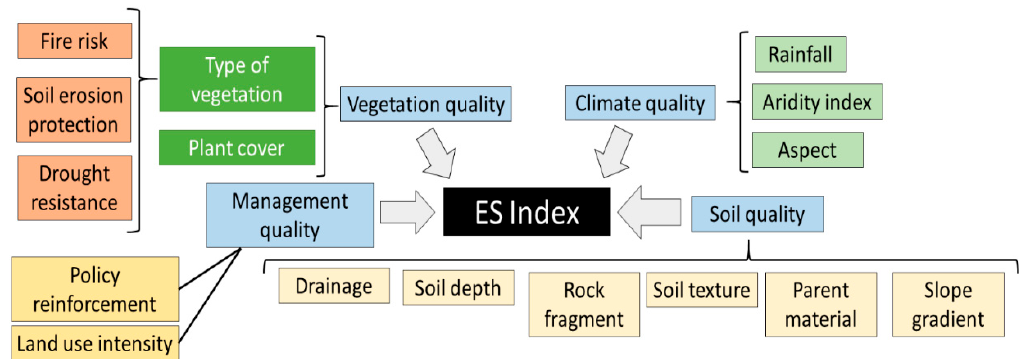
Figure 3. A graphical workflow of input variables and partial indicators adopted in the ESA (Environmentally Sensitive Area) framework to estimate sensitivity to soil degradation.